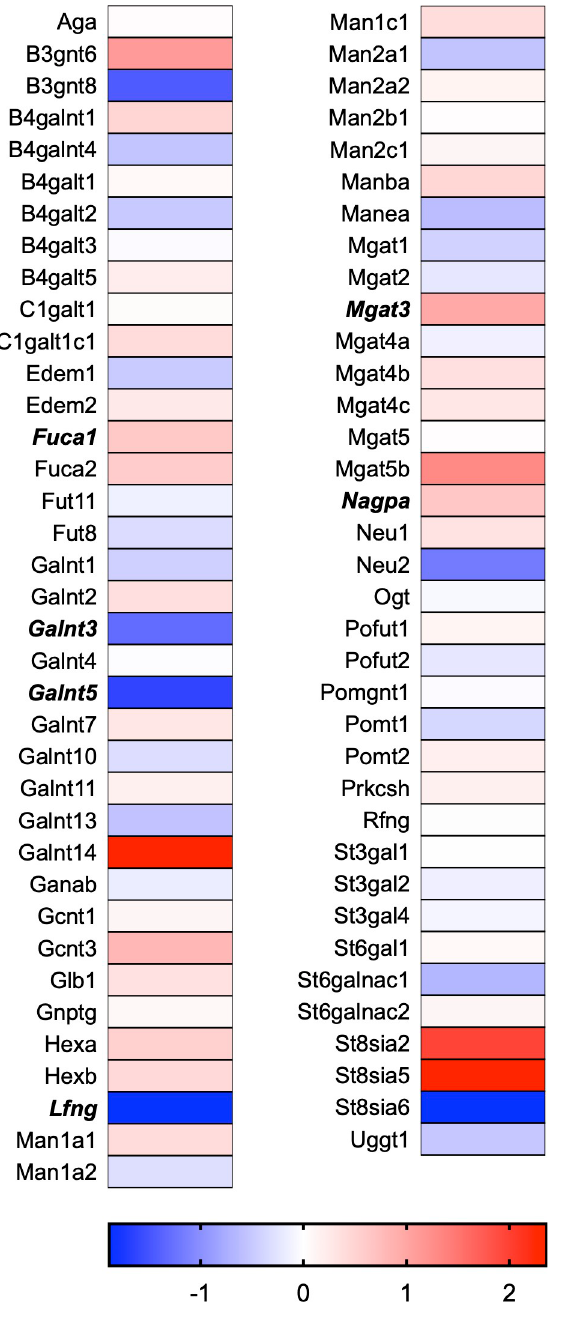
Fig 20. Glycosylation heat map. Bold text indicates significantly altered gene